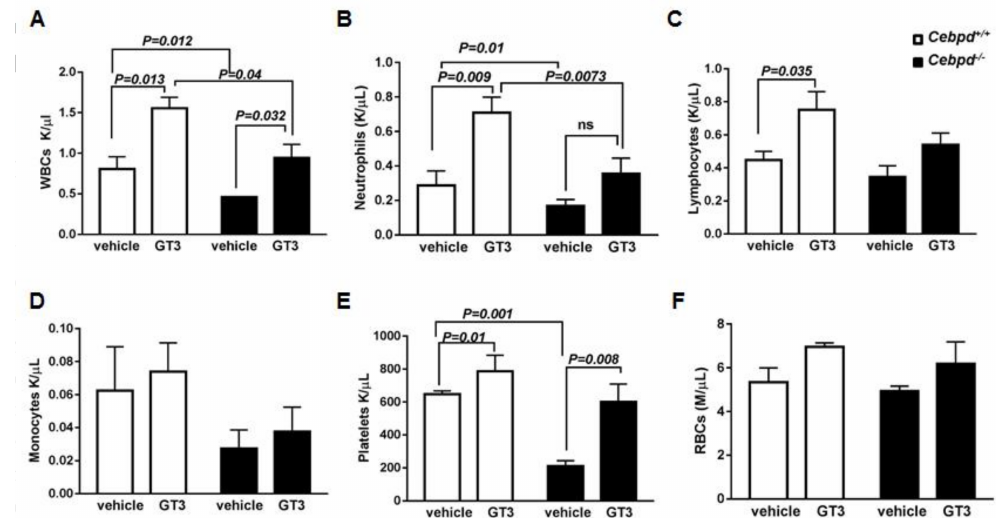
Figure 1. GT3 pre-treatment showed partial rescue of the blood cells in irradiated Cebpd − / − mice. Peripheral blood cell counts ( A ) WBCs, ( B ) Neutrophils, ( C ) Lymphocytes, ( D ) Monocytes, ( E ) platelets and ( F ) RBCs from vehicle- and GT3-treated Cebpd + / + and Cebpd − / − mice at 2 weeks after exposure to 6 Gy. Data are expressed as mean + standard error mean (S.E.M.) and obtained from n = 4–5 mice/genotype/group. p < 0.05 was considered statistically